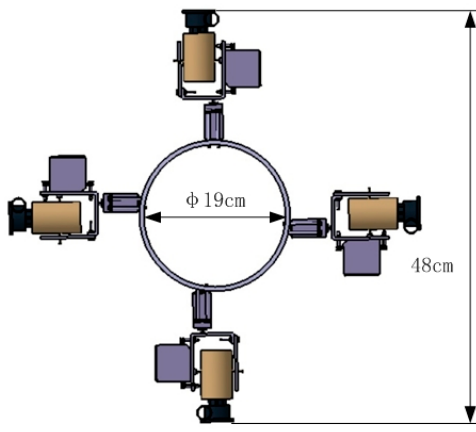
Figure 4. Propulsion system of SURIII.